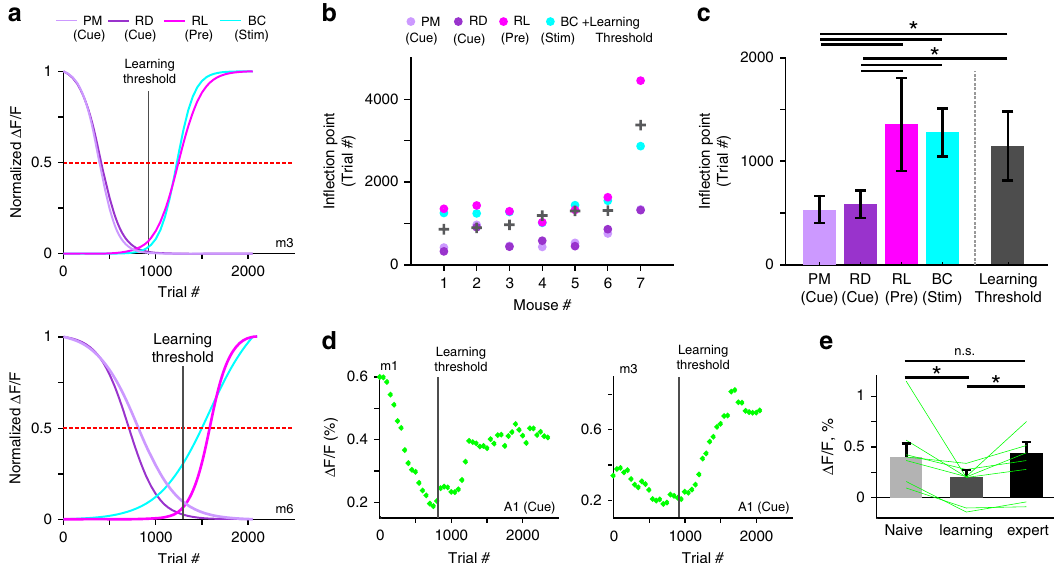
Fig. 4 PM and RD suppression occurs before learning and precedes RL and BC enhancement. a Normalized sigmoidal fi ts to the learning-related mean Δ F / F changes in PM and RD (for cue-period), in RL (for pre-period), and in BC (for stim-period) for two example mice. Horizontal dashed red line indicates 0.5-level for determining steepest points of change. Vertical solid gray line indicates the learning threshold of the mouse. b Steepest points of change for all mice in each of the four areas. Learning threshold is marked with a gray plus sign (similar to Fig. 1g). c Steepest points of change (in fl ection points) and learning threshold averaged across mice. Error bars are s.e.m. across mice. d Learning-related Δ F / F changes in A1 during the cue-period for two example mice. Vertical gray line indicates learning threshold. e Mean Δ F / F changes in A1 during the cue-period for naïve, learning, and expert mice. Error bars are s.e.m. across mice. Lines depict individual mice. * p < 0.05; n.s. not signi fi cant; Wilcoxon signed-rank